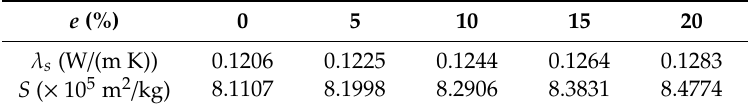
Table 2. Influence of stochastic error e in the measured data on the identified conductivity of nanometer-sized skeleton and specific area.